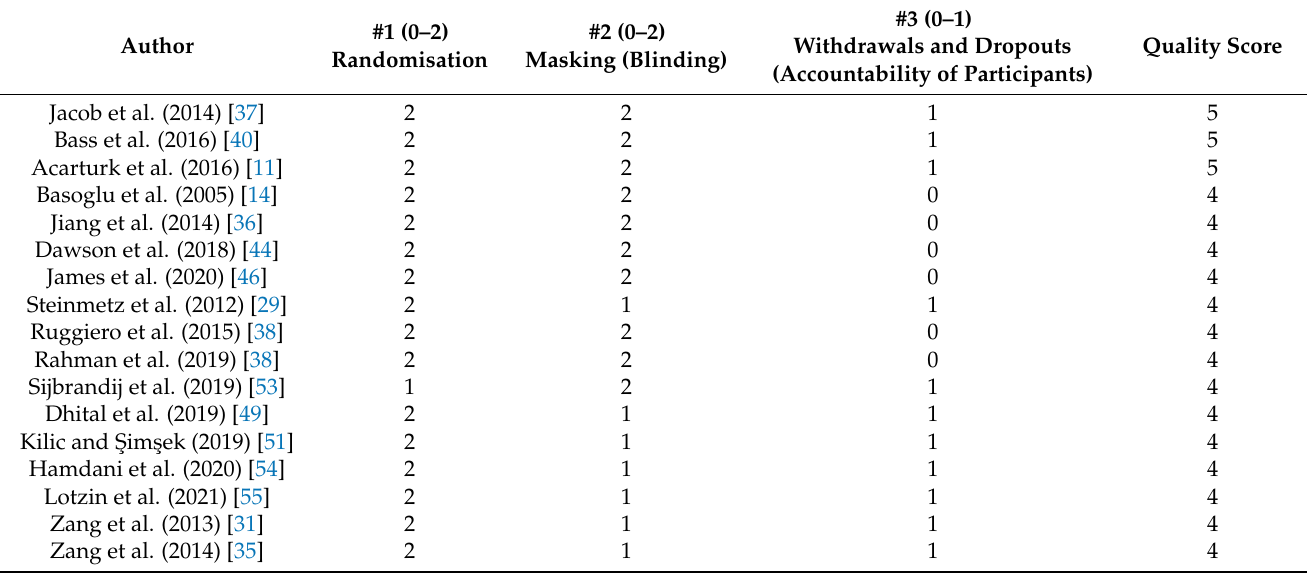
Table 2. Quality Assessment of randomised controlled studies using the Jadad Scale.